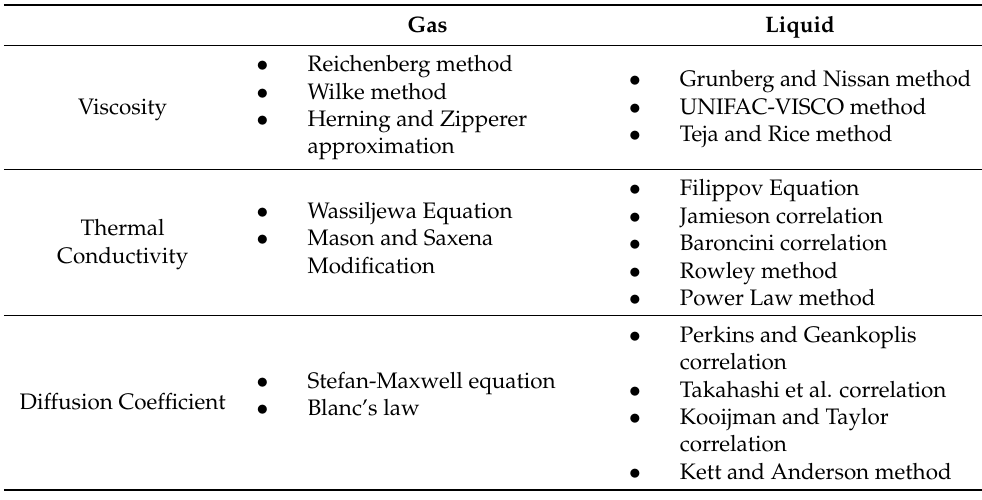
Table 1. Examples of different methods to calculate the transport properties of a multi-component gas or liquid phase